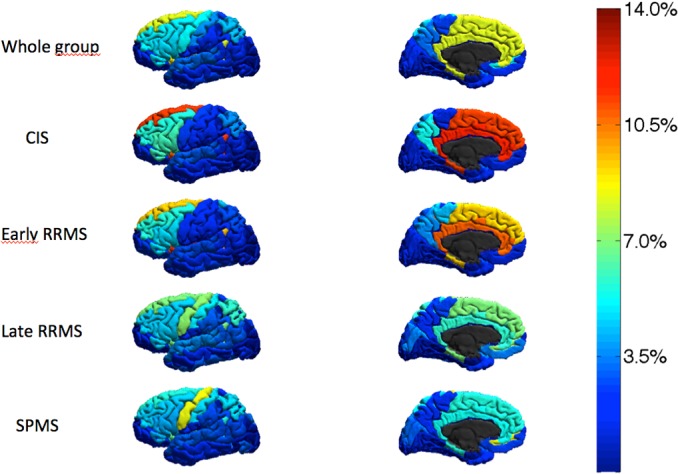
3D Regional map of the frequency of the appearance of new grey matter lesions during the 5-year follow up in the whole group and in the different MS subsets.